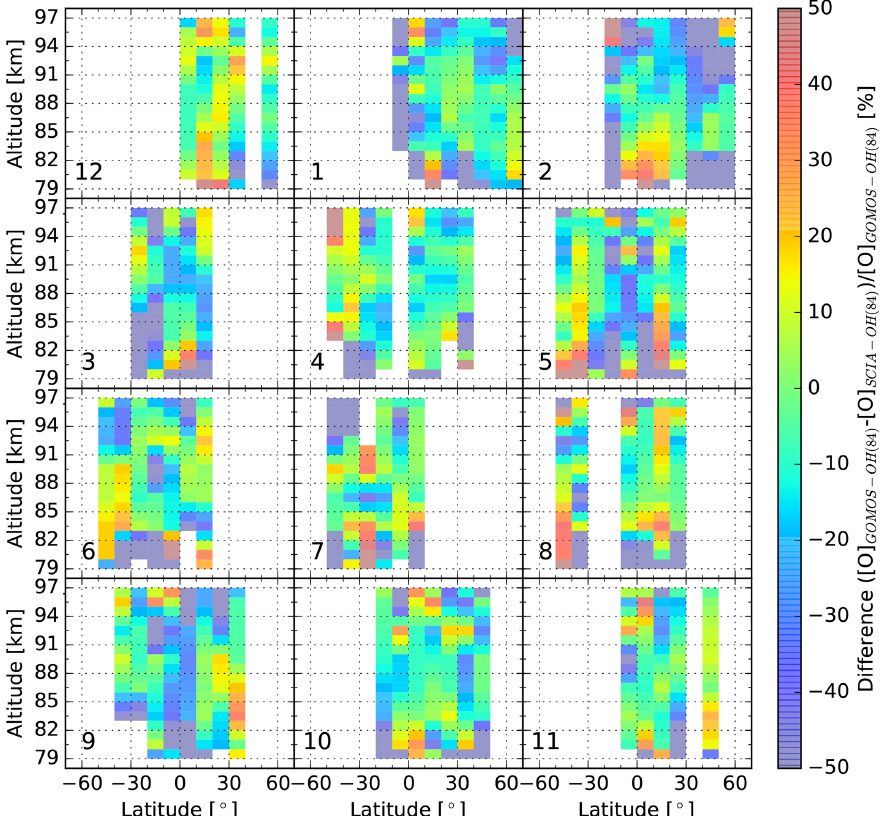
Figure 13. Latitude–altitude distribution of percentage differences between zonal mean atomic oxygen densities derived from GOMOS and SCIAMACHY OH(8–4) airglow emissions for 2007. Each row represents approximately a season. Negative numbers indicate that SCIAMACHY abundances are larger than those obtained from GOMOS. The data are linearly interpolated into a 1km altitude grid. The numbers in the subplots indicate the month of the